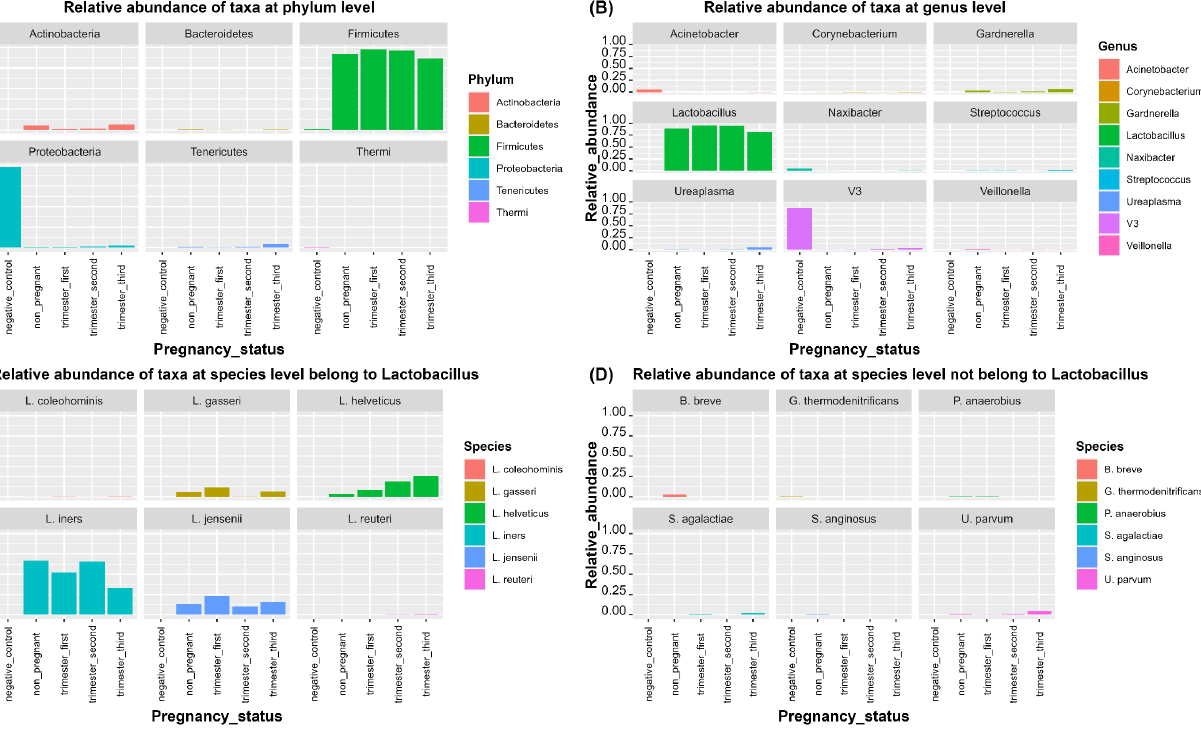
Figure 1. Relative abundance of taxa across the three trimesters of pregnancy in comparison to non-pregnant state. ( A ) Relative abundance of taxa at phylum level. ( B ) Relative abundance of taxa at genus level. ( C ) Relative abundance of Lactobacillus species. ( D ) Relative abundance of non- Lactobacillus species (Figure 1D is re-represented as Supplementary Figure S4 with different y-scale to show the relative abundance of minor non- Lactobacillus species). Negative control represents samples with empty swab for DNA extraction and amplified nuclease-free water without extracted DNA.